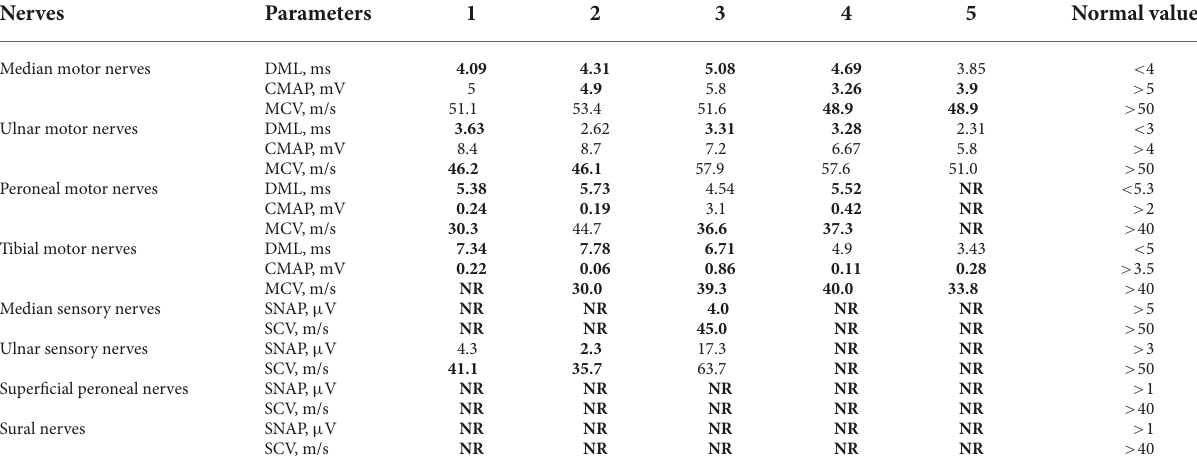
TABLE 3 Neuro-electrophysiological features of symptomatic ATTRv patients with the Glu61Lys variant. Nerves Parameters 1 2 3 4 5 Normal values Median motor nerves DML,